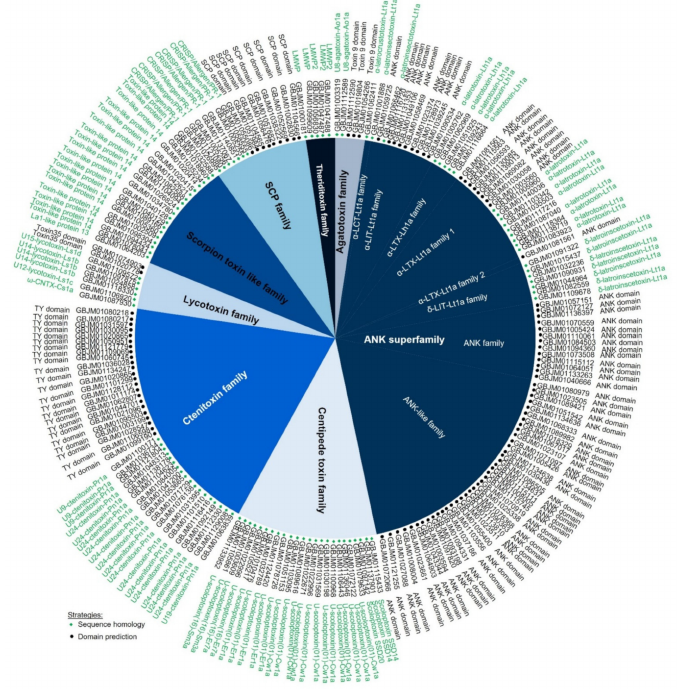
Figure 6. Toxinome of L. geometricus venom gland. All 212 unigenes were clustered using sequence homology and domain